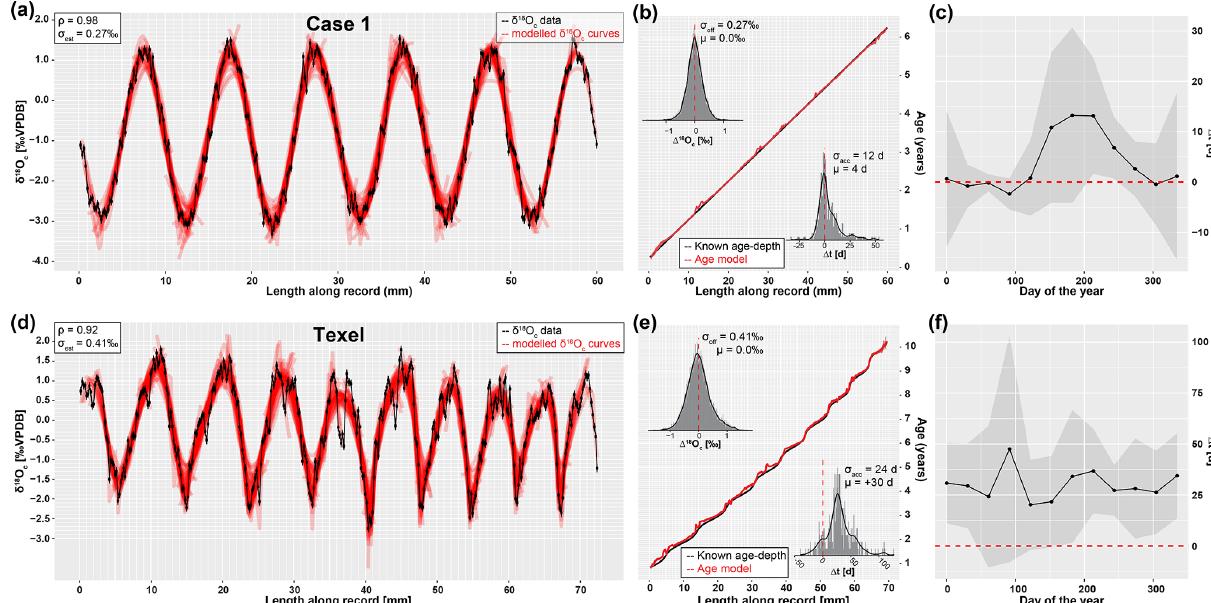
Figure 6. Result of applying ShellChron to two virtual datasets: Case 1 (top, see SI8) and Texel (bottom, see SI9). Leftmost panels (a, d) show the model fit of individual sample windows (red) on the data (black, including horizontal and vertical error bars), with Spearman’s correlation coefficients ( ρ ) in the top left and standard deviations of the δ 18 O c estimate ( σ est ). Middle panels (b, e) show the resulting age model (red, including shaded 95% confidence level) compared with the known age–distance relationship of both records. Histograms in the top left of age–distance plots show the offset between modeled and measured δ 18 O c (as visualized in panels a and d ) with standard deviations of the δ 18 O c offset ( σ off ) and offset averages ( µ ). Histograms in the bottom right of age–distance plots show the offset between modeled and known ages (in days) of each data point, including standard deviations of the age accuracy ( σ acc ) and mean age offset ( µ ). Rightmost panels (c, f) highlight age offsets binned in 12 monthly time bins based on their position relative to the annual cycle to illustrate how accuracy varies over the seasons. Grey envelopes indicate 95% confidence levels for the monthly age offset within these monthly time bins. The horizontal red dashed line indicates no offset (modeled age is equal to the known age of the